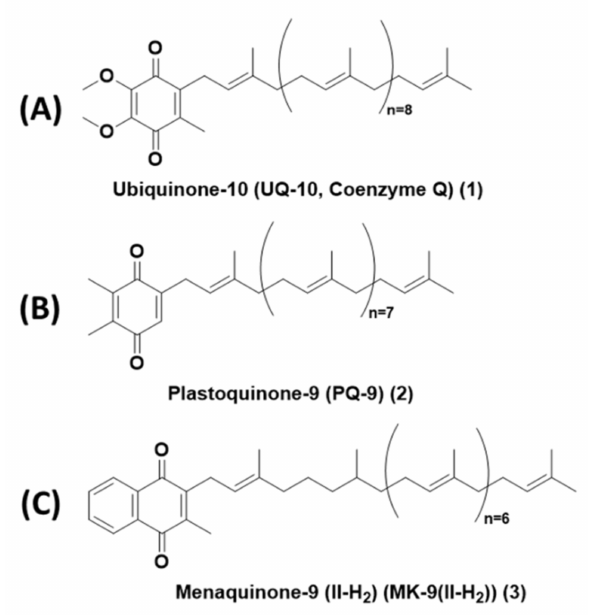
Figure 1. Structures of representative lipoquinones from each subclass. ( A ) Ubiquinone-10, also known as Coenzyme Q10 or UQ-10. ( B ) Plastoquinone-9 (PQ-9). ( C ) Menaquinone-9(II-H 2 ) (MK-9(II-H 2 )). The 1,4-quinone headgroup is responsible for the redox activity of lipoquinones. If